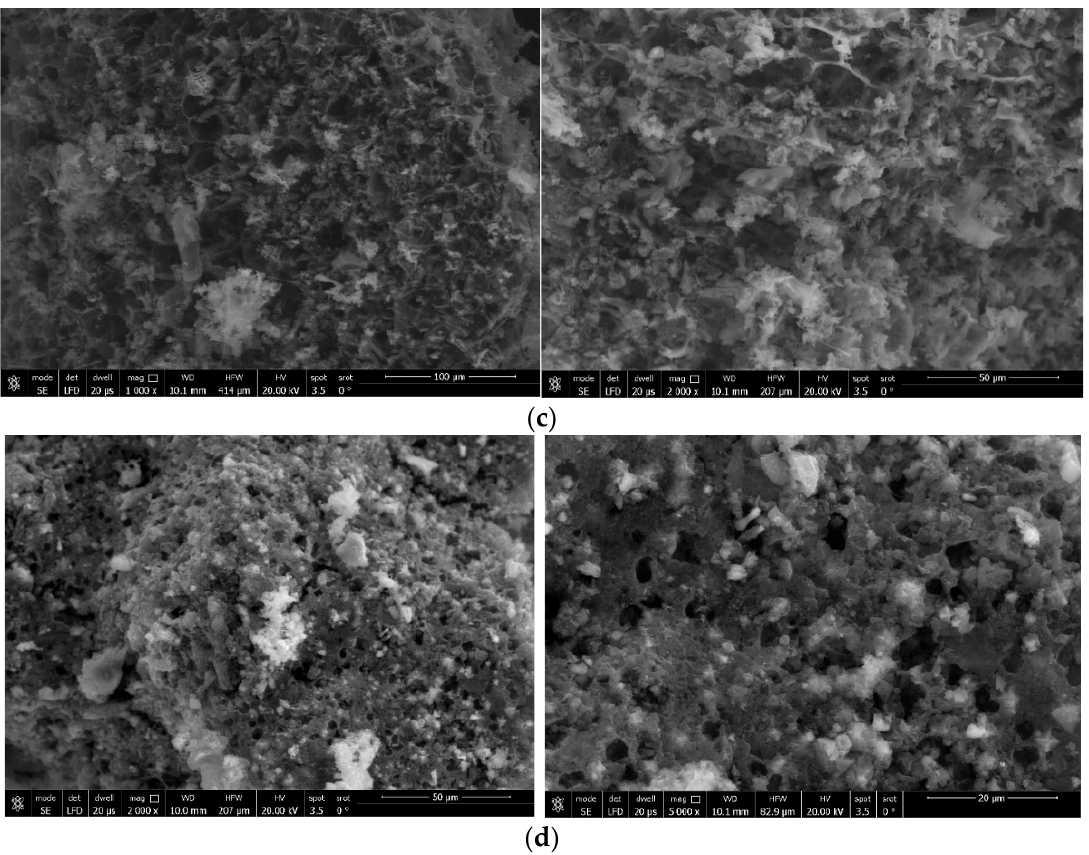
Figure 2. SEM images of ( a ) waste tea leaf, ( b ) carbon material resulted from the pre-carbonization of waste tea leaf, ( c ) biomass-derived-ACs material, and ( d ) Fe 3 O 4 -carbon-based composite.